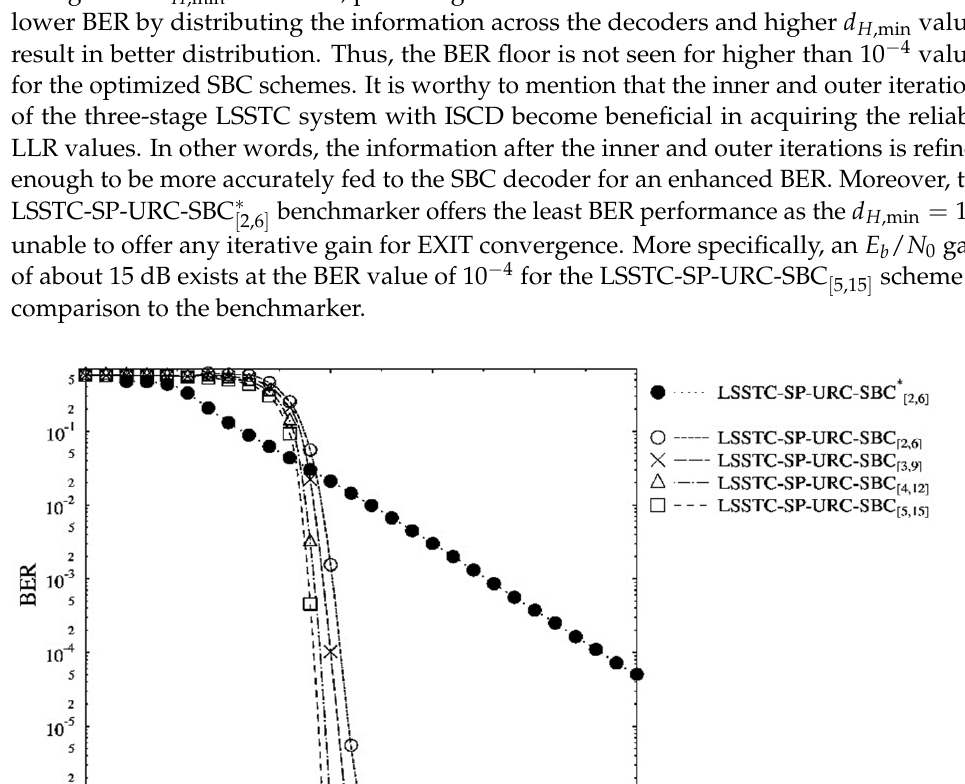
Figure 3. Outer and inner EXIT curves for the LSSTC-SP-URC- SBC [(cid:2870),(cid:2874)] scheme along with Monte- Carlo based decoding trajectories at 𝐸 (cid:3029) /𝑁 (cid:2868) = 8 to 13 dB.